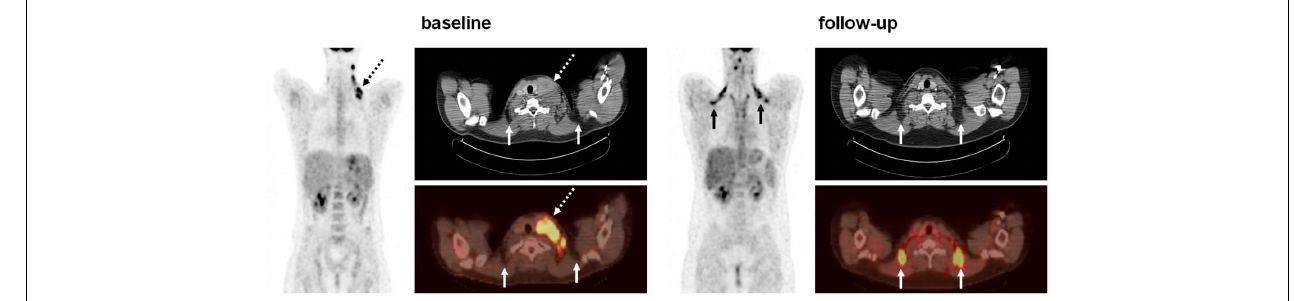
image, note that the lymph node mass is characterized by soft-tissue-like attenuation. At follow-up, the subject exhibits clear bilateral FDG uptake indicative of BAT.This is confirmed on the CT images which show negative fat-like attenuation (solid arrows). In contrast, the corresponding BAT depots on the baseline axial images do not exhibit FDG uptake. Note that the enlarged lymph node has been successfully